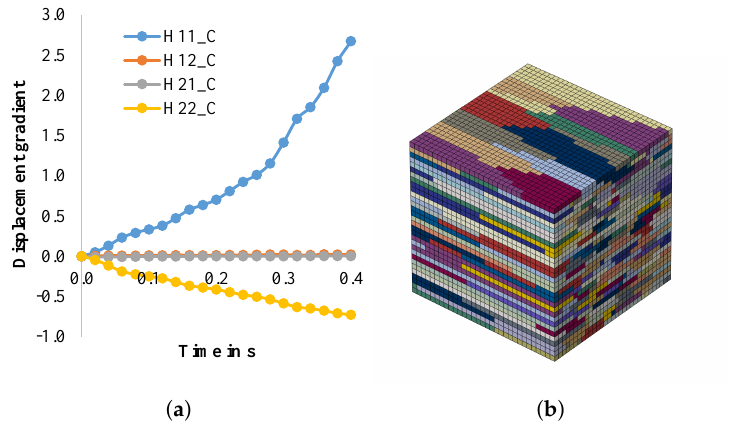
Figure 8. ( a ) displacement gradient during rolling of Fe3.2wt.%Si with a banded microstructure in the mid-layer, ( b ) corresponding RVE with 300